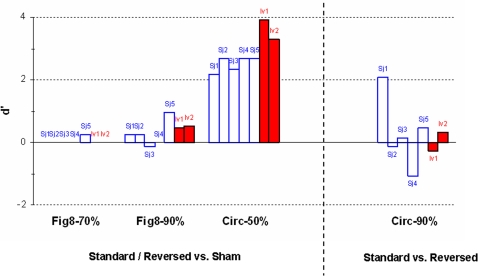
Perceptual Discrimination.Ability of five naive subjects (Sj1–Sj5; white bars) and two non-naïve investigators (Iv1, Iv2; red bars) to discriminate between stimulus conditions, expressed in terms of d' statistic (higher d' = greater discriminability). Discriminability between Real (Standard or Reversed) vs. Sham TMS through the Fig8 coil with stimulator at 70 and 90% of maximum stimulator output, and through the Circ coil at 50%. Also, discriminability between Standard and Reversed in the Circ coil with stimulator at 90%.